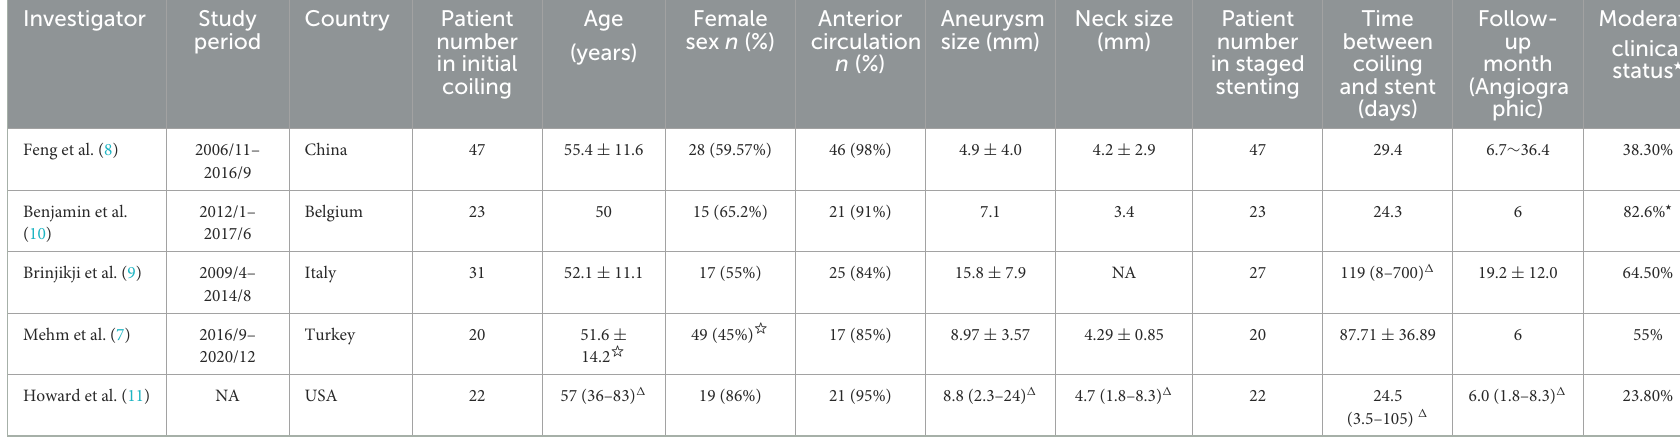
TABLE 2 The basic characteristics of the included eligible studies. Investigator